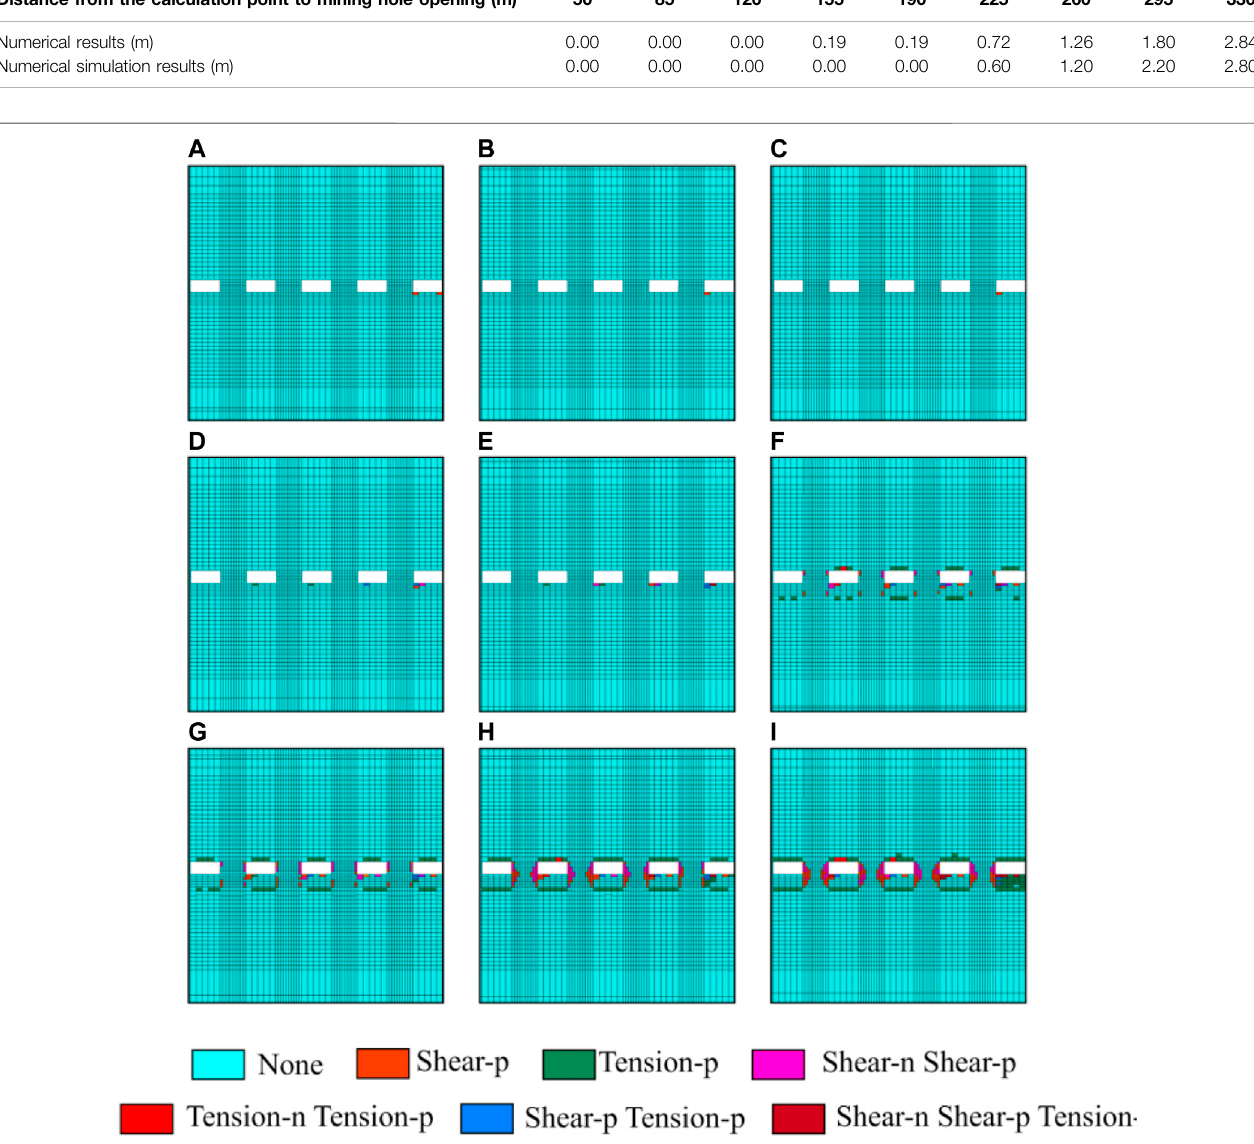
TABLE 10 | Inelastic zone width of the coal pillar calculated by numerical calculation and numerical simulation under the 50% fi lling rate condition. Distance from the calculation point to mining hole opening (m) 50 Numerical results (m)